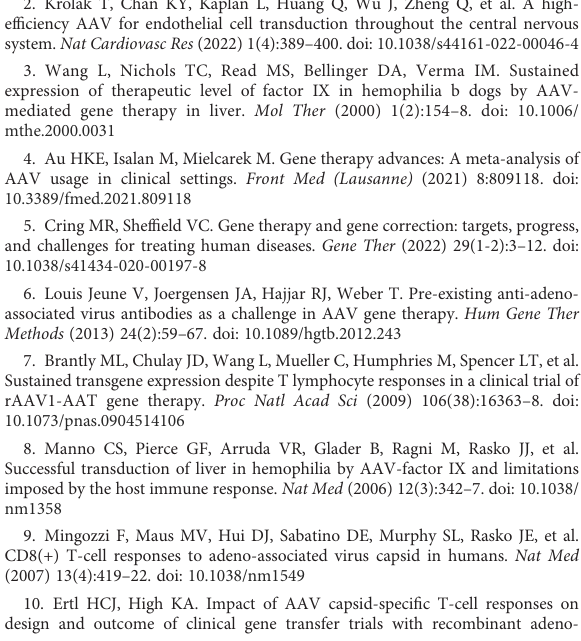
SUPPLEMENTARY TABLE 1 Full peptides list and alignment to the protein sequence. Related to Figures 1 – 3.